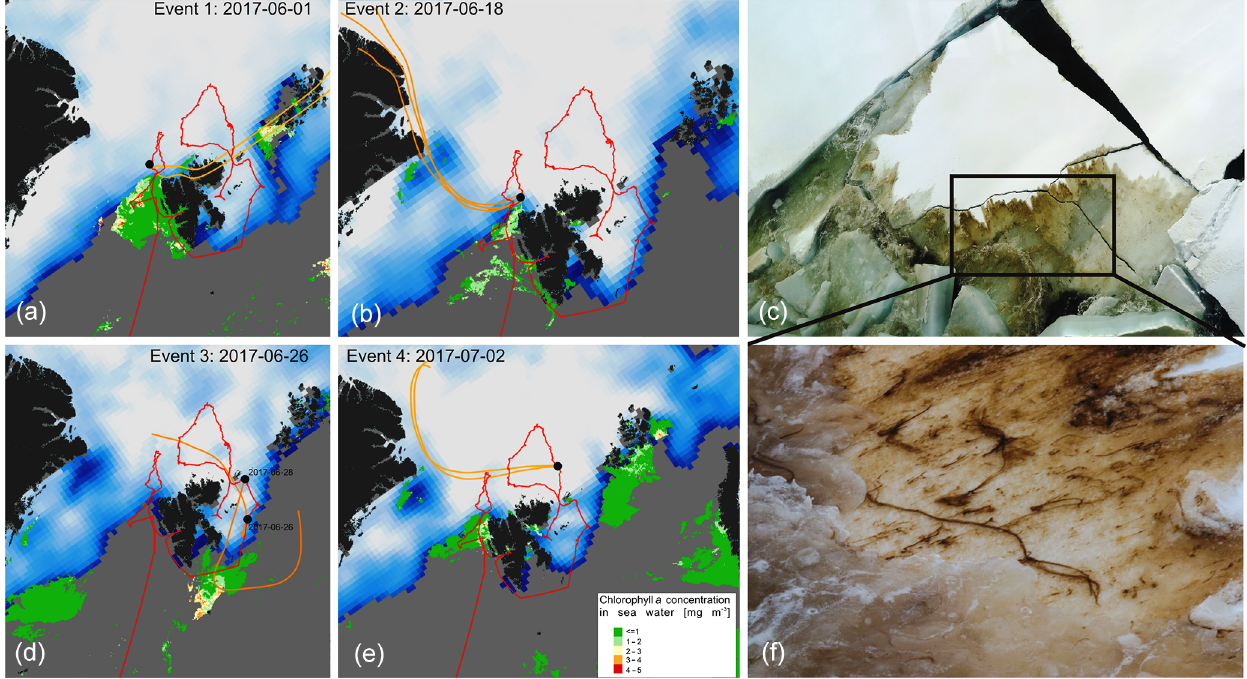
Figure 5. Sea-ice concentration (white – 100%, dark blue – 1%; from NASA Worldview; Maslanik and Stroeve, 1999) and chlorophyll- a surface concentration (taken from http://marine.copernicus.eu, last access: 29 April 2019) during NPF events (a, b, d, e) . On the right – the ice alga and diatom Melosira arctica (c, f) observed from the ship deck during NPF Event 1. RV Polarstern track and location during the NPF event are indicated by the red line and black circle, respectively. Orange lines mark the 72h backward air mass trajectory at